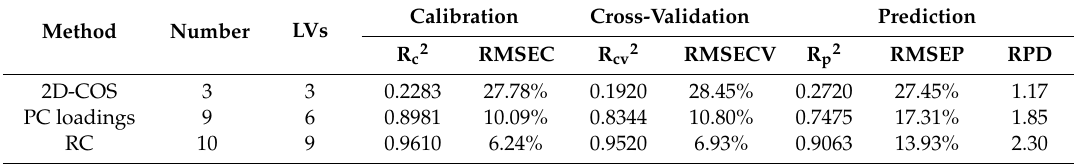
Table 2. Performance of simplified PLSR models based on wavelengths selected by three methods.